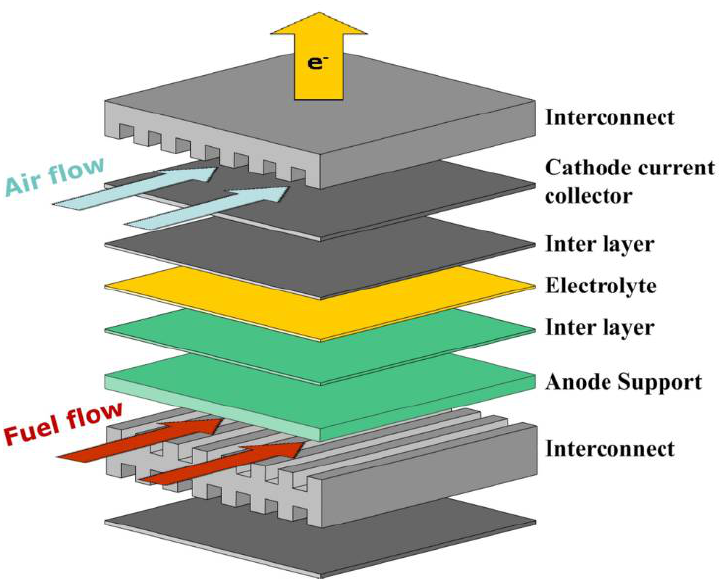
Figure 6. Schematic of SOFC with interconnect–anode–electrolyte–cathode cells. The metal interconnects are brazed to the ceramic electrodes [115].